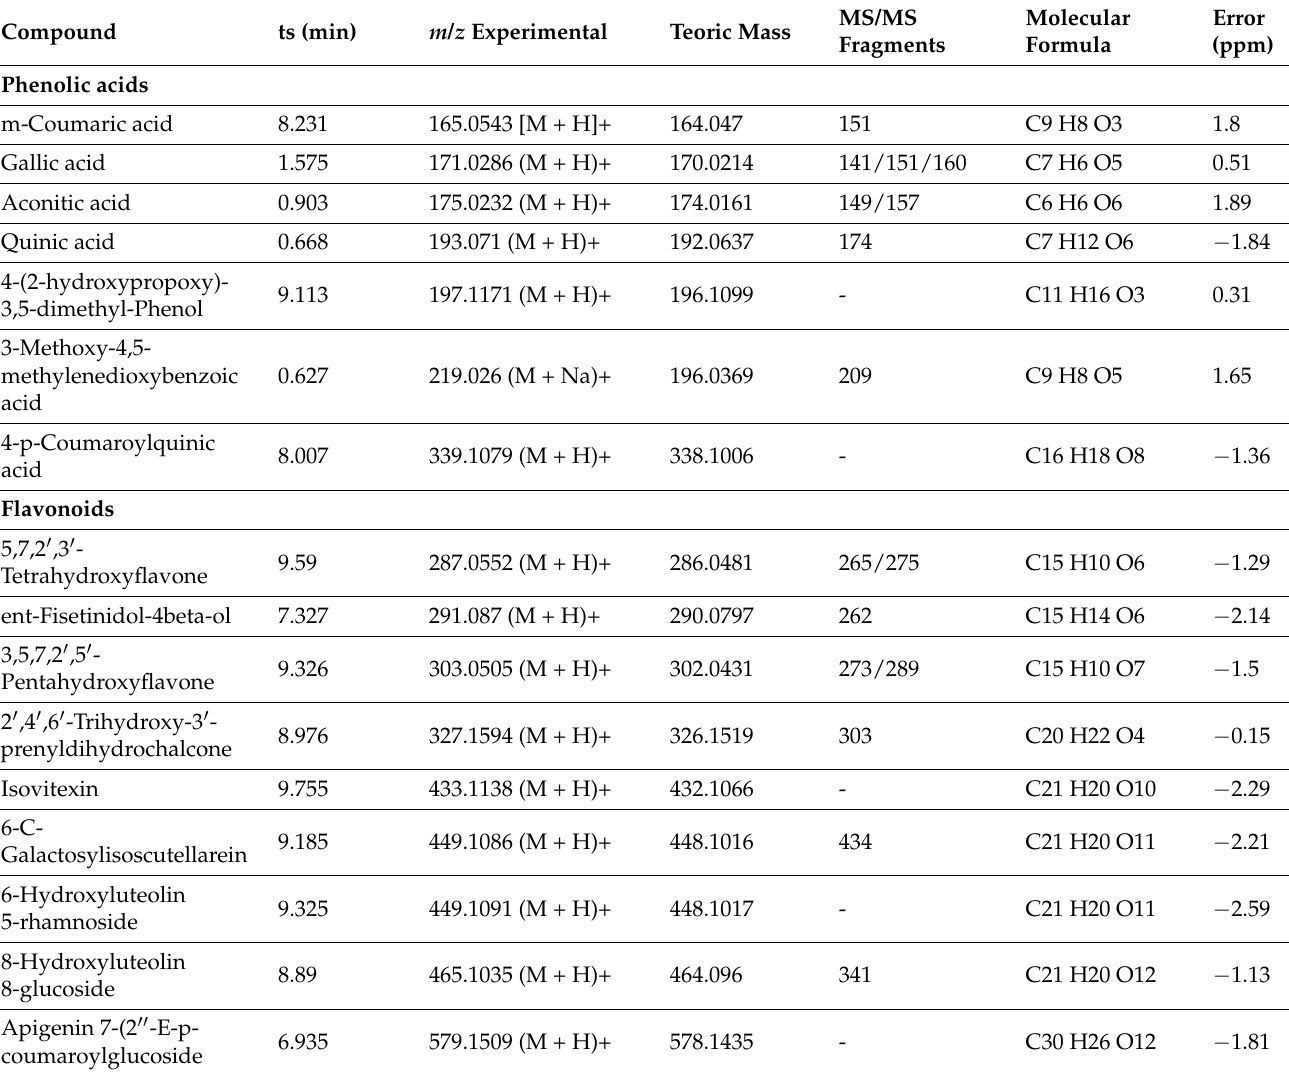
Table 3. Phytochemical profile of the aqueous extract of A. angustiloba leaves by LC–MS in the positive ion